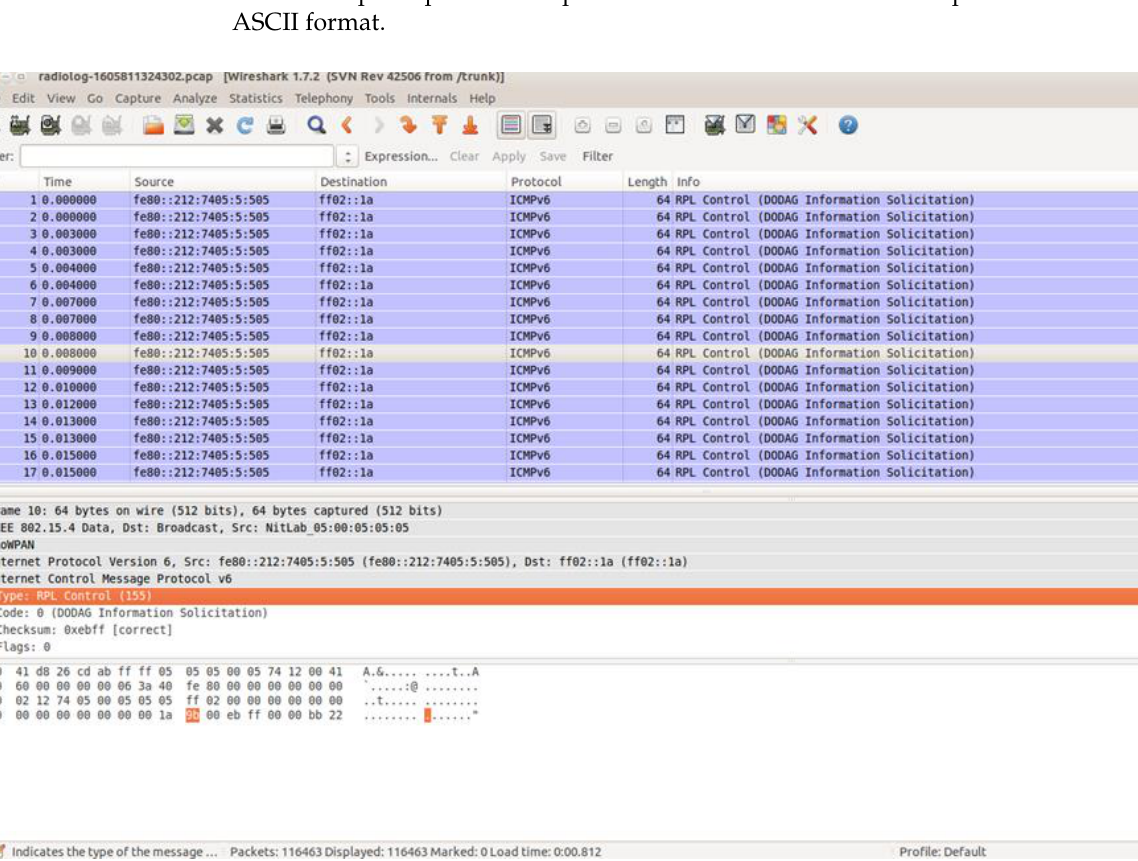
Figure 17. The first seventeenth packets in the “radiolog - 1605811324302.pcap” file .